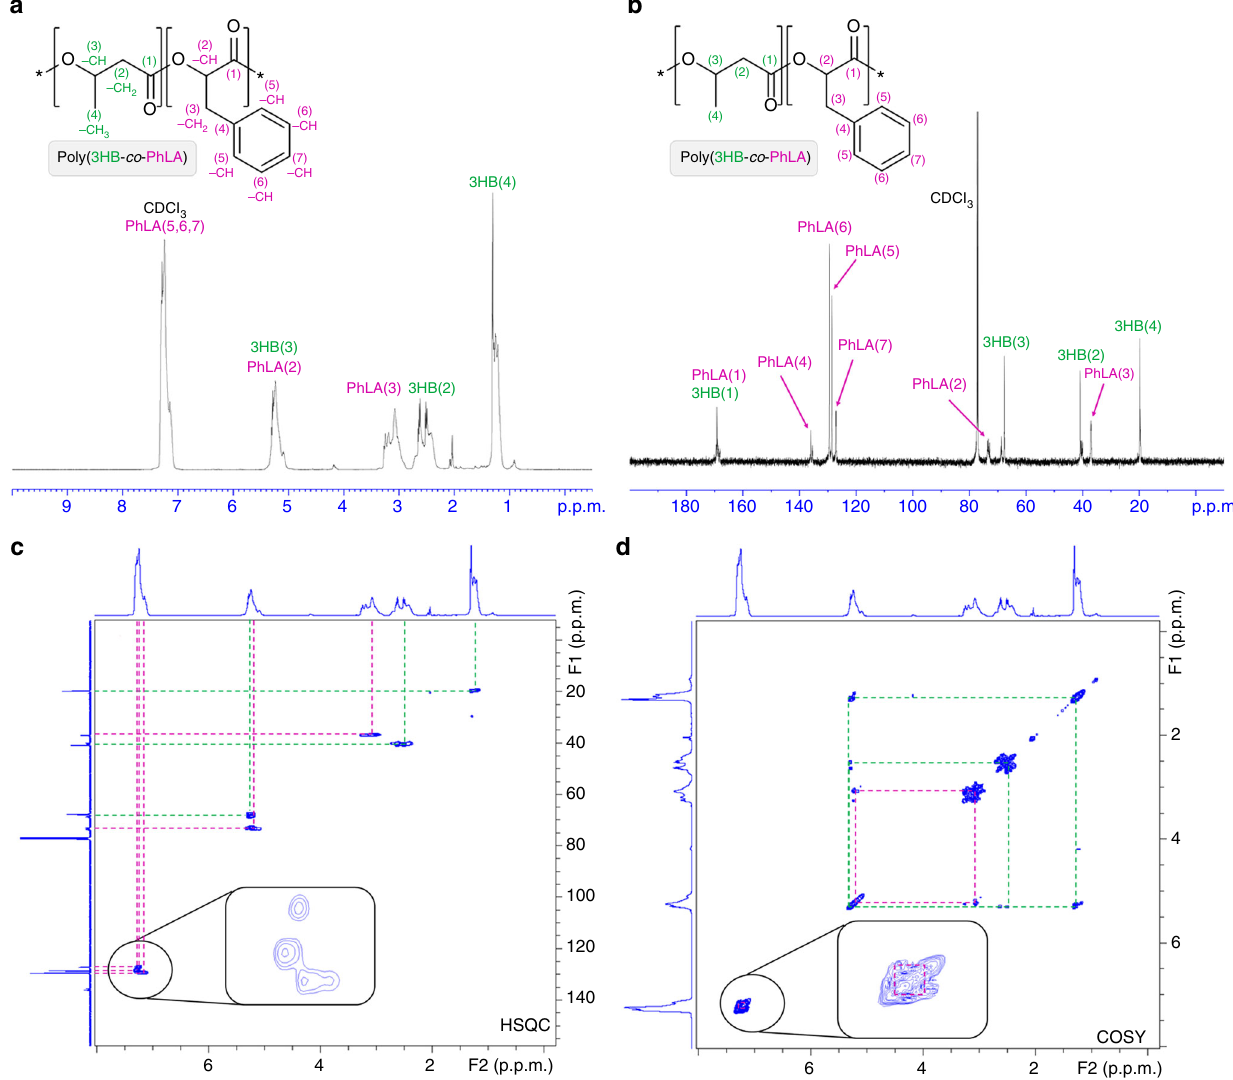
Fig. 3 Characterization of aromatic PHAs produced by metabolically engineered E. coli . a – d NMR spectra of poly(3HB- co - D -phenyllactate) produced in E. coli XB201TBAL expressing AroG fbr , PheA fbr , FldH, HadA, and PhaC1437. a 1 H NMR. b 13 C NMR. c 2D 1 H- 13 C HSQC NMR. d 2D 1 H- 1 H COSY